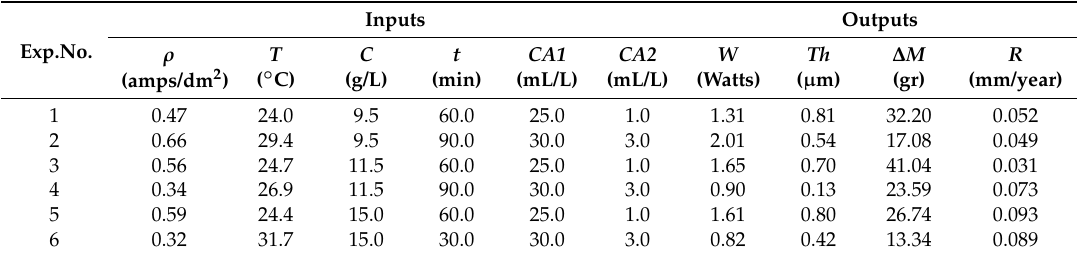
Table 8. Parameters of six additional zinc-coated steel screws used for testing the proposed regression model.